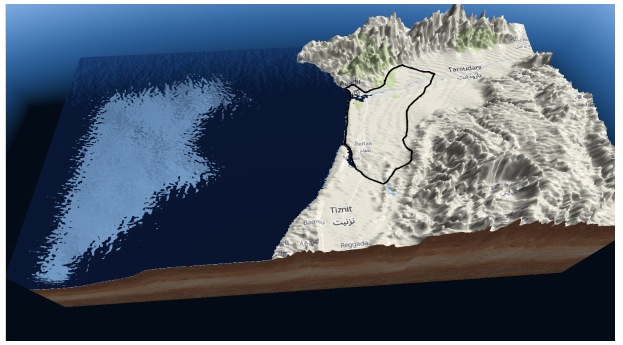
Figure 7. Study area and geolocation of the aquifer.